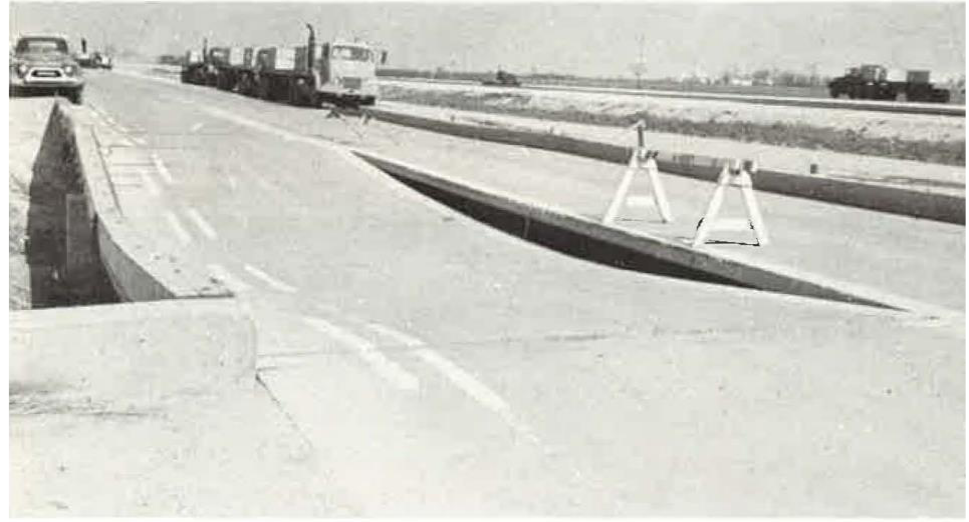
Figure 3. Bridge testing at AASHO Road Test [21].